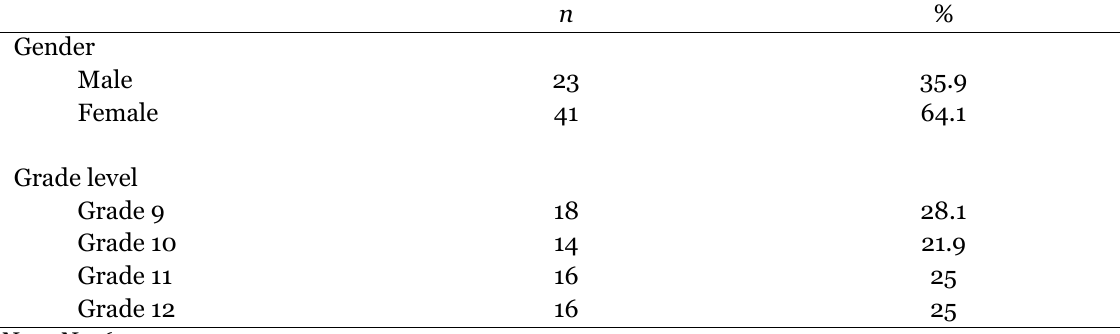
Individual and School Characteristics of Fourth Study Group n % Gender Male 23 35.9 Female 41 64.1 Grade level Grade 9 18 28.1 Grade 10 14 21.9 Grade 11 16 25 Grade 12 16 25 Note. N =